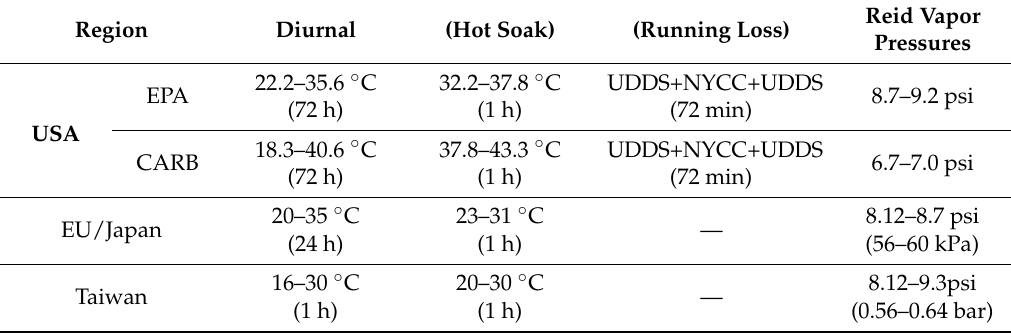
Table 1. Test requirements of evaporative emission control (EVAP) in different regions [13].